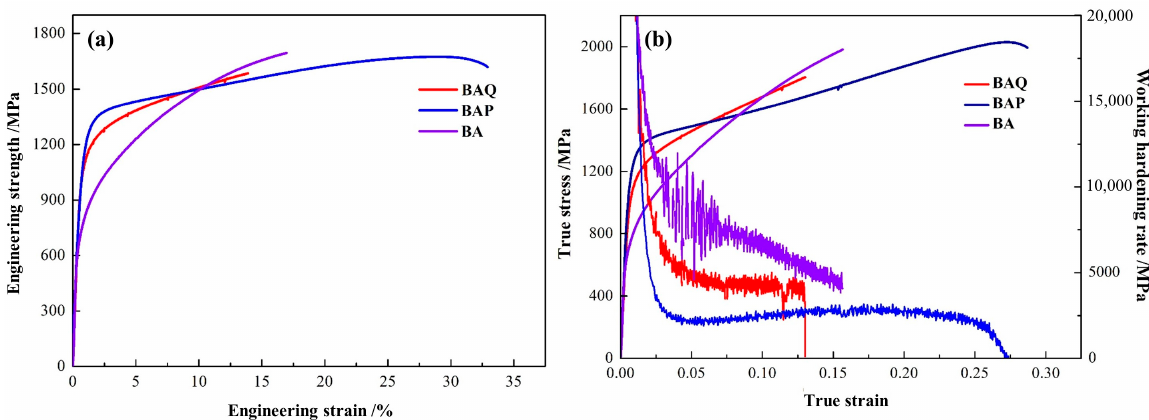
Figure 2. ( a ) The engineering strength and strain curves; ( b ) the corresponding work hardening rate curves. Table 1. The mechanical properties of BA (bainitic austempering), BAQ (bainitic austempering- quenching), and BAP (bainitic austempering-partitioning) treatments. Samples